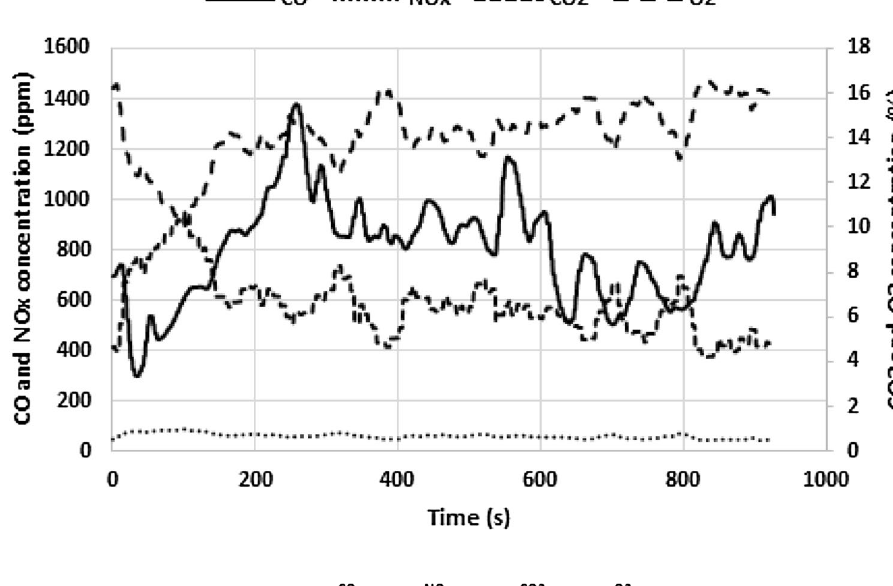
Fig. 7 Gases concentrations measured in the fume exhaust: CO (solid line, ppm), NOx (dotted line, ppm), CO hyphened line, %) and O (large hyphened line,